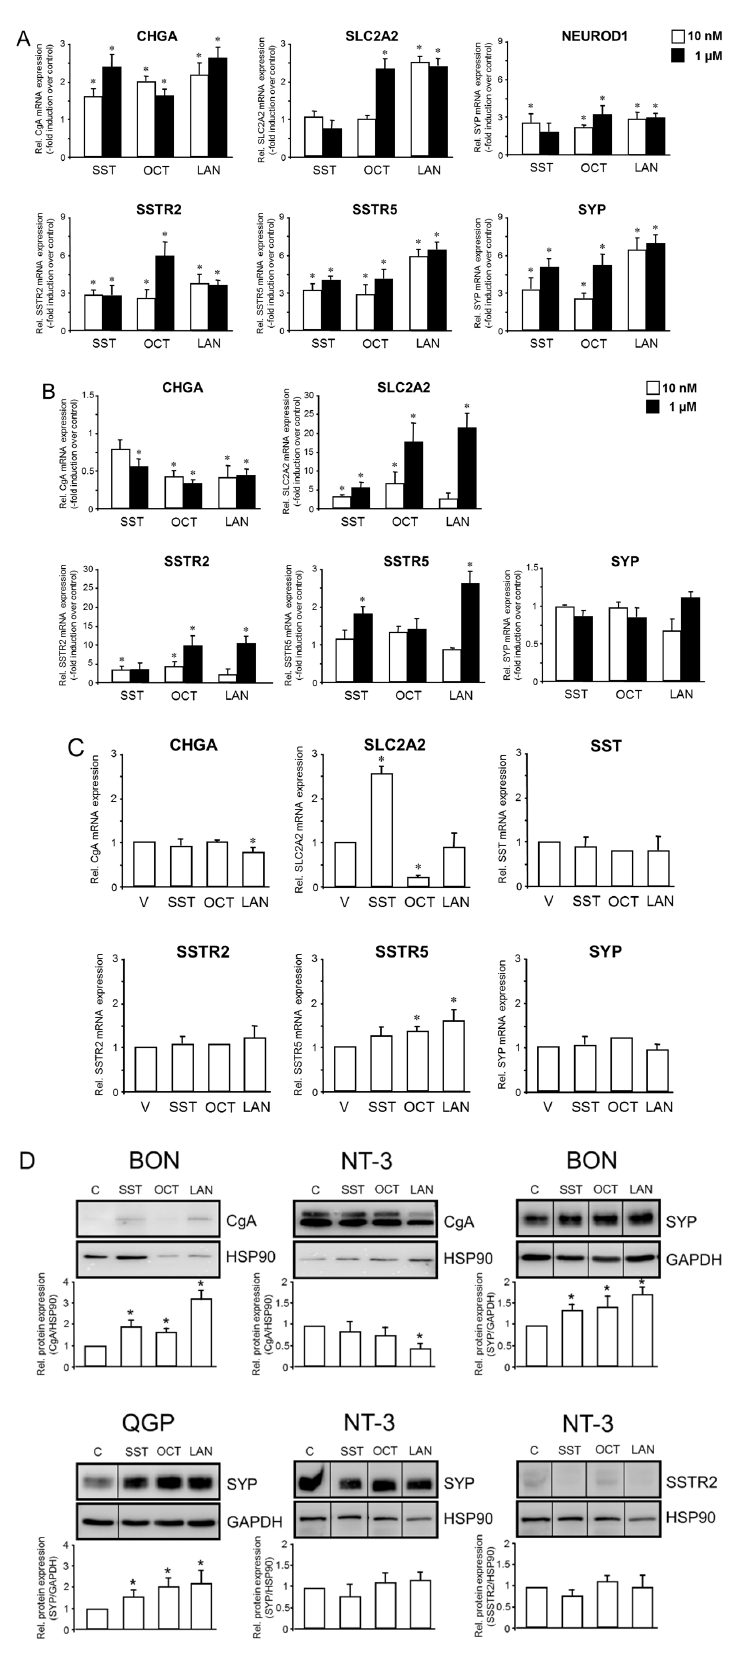
Figure 1. Response of various NE markers to treatment with SST or SSAs in BON, QGP, and